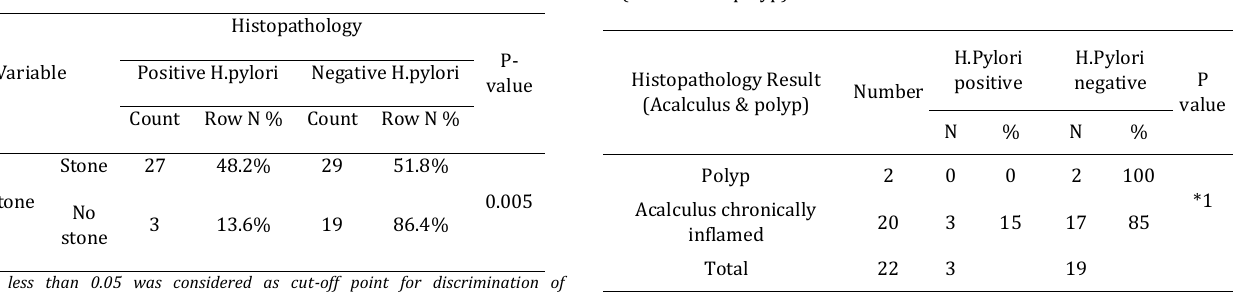
Association between H.Pylori infection and Gallstone.